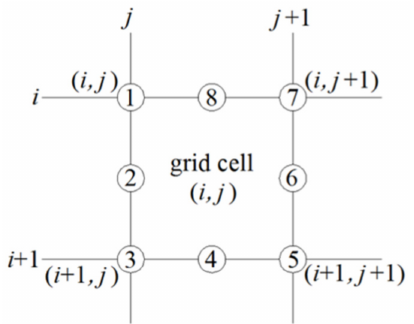
Figure 13. Numbering calculation of nodes constituting an SMS quadrilateral grid cell (“ i ” and “ i + 1” represent the serial numbers of the adjacent longitudinal grid lines; “ j ” and “ j + 1” represent the serial numbers of the adjacent transverse grid lines; the cell serial number is marked by the combination ( i , j ); and “ 1 (cid:13) ~ 8 (cid:13) ” are the node numbers constituting the